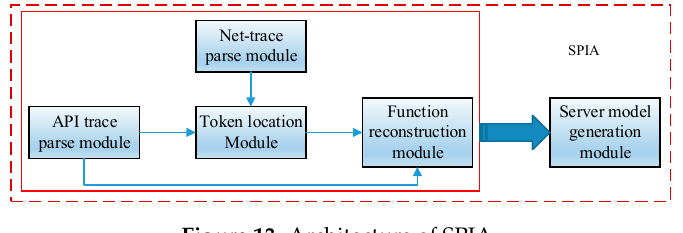
Figure 13. Architecture of SPIA.